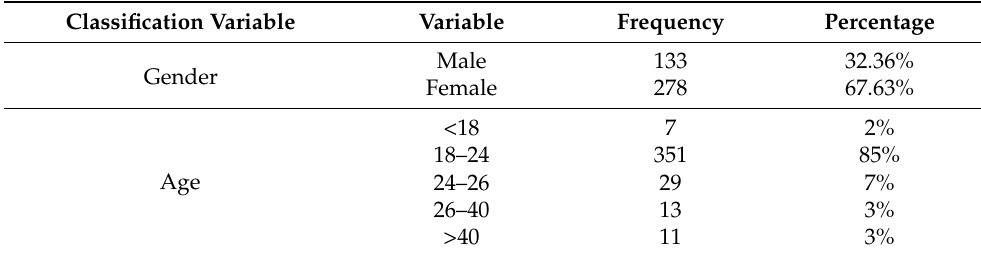
Table 1. Sample Characteristics ( n =